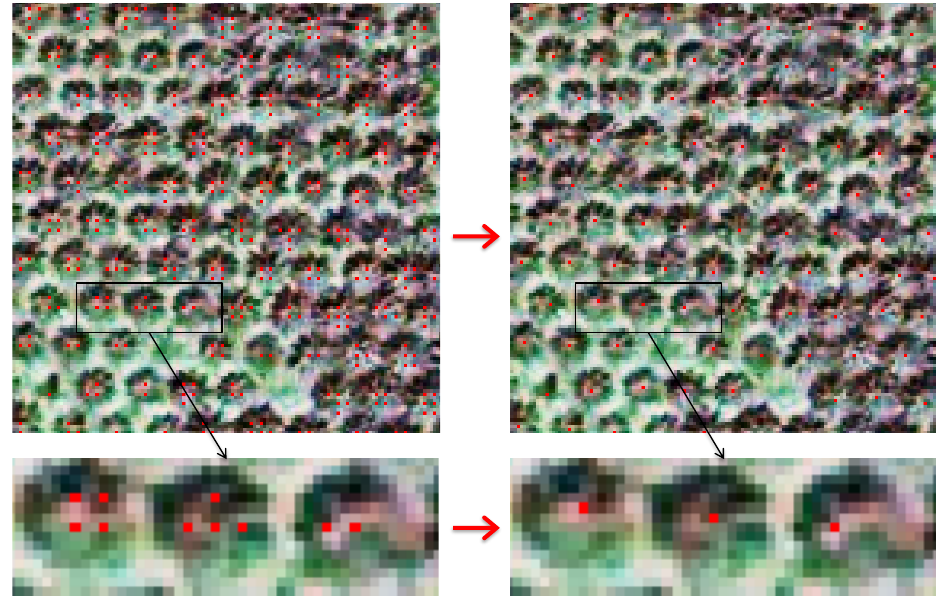
Figure 5. Sample